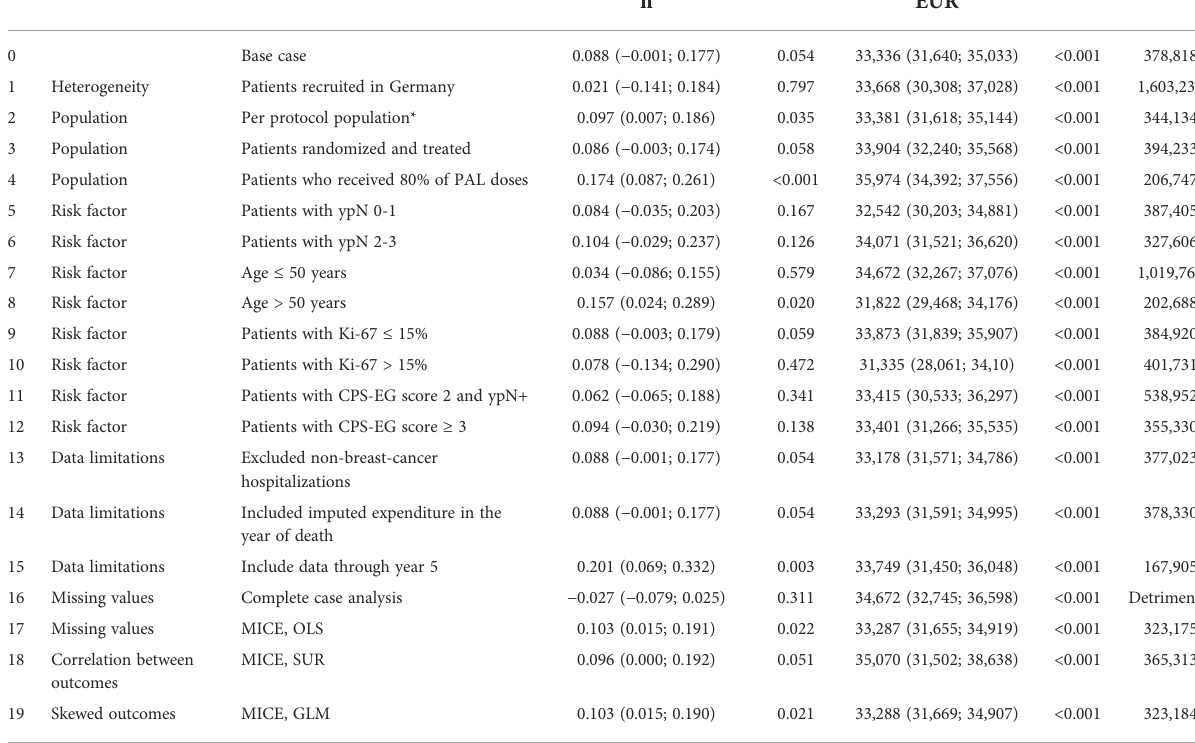
TABLE 4 Scenario analyses: regression-adjusted, 4 years of